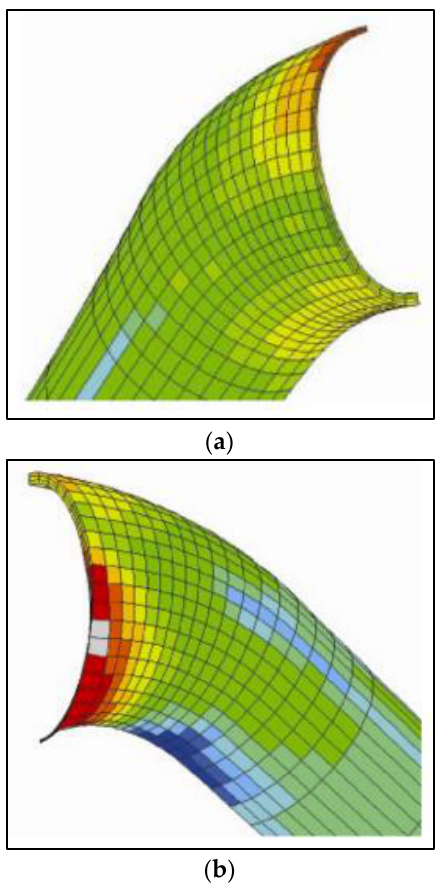
Figure 9. Deformation of pipe bend with corrosion defect for opening bending moment at the ( a ) extrados and ( b ) intrados [38].